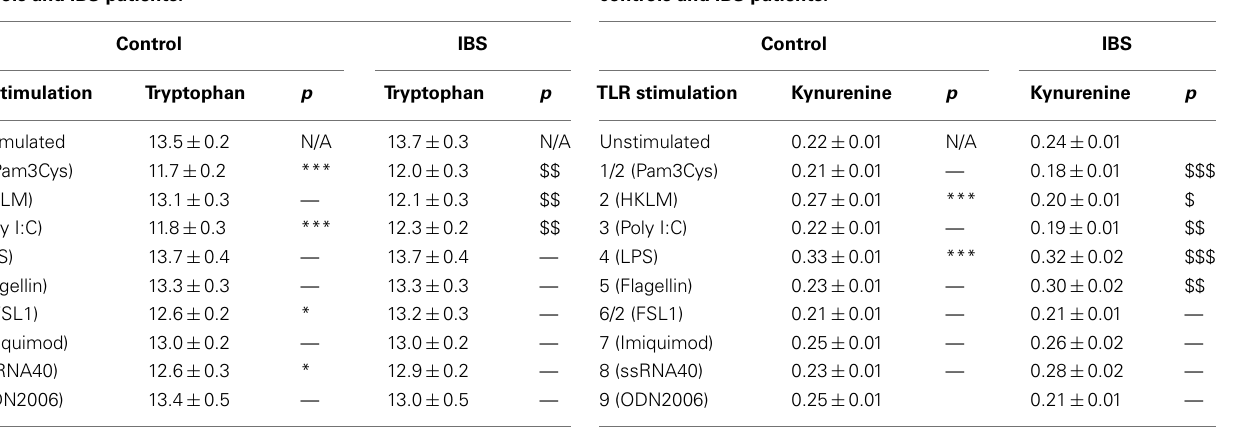
Table 2 | Kynurenine concentrations ( μ gmL − 1 ) in unstimulated and TLR agonist stimulated whole blood supernatants from healthy controls and IBS patients.